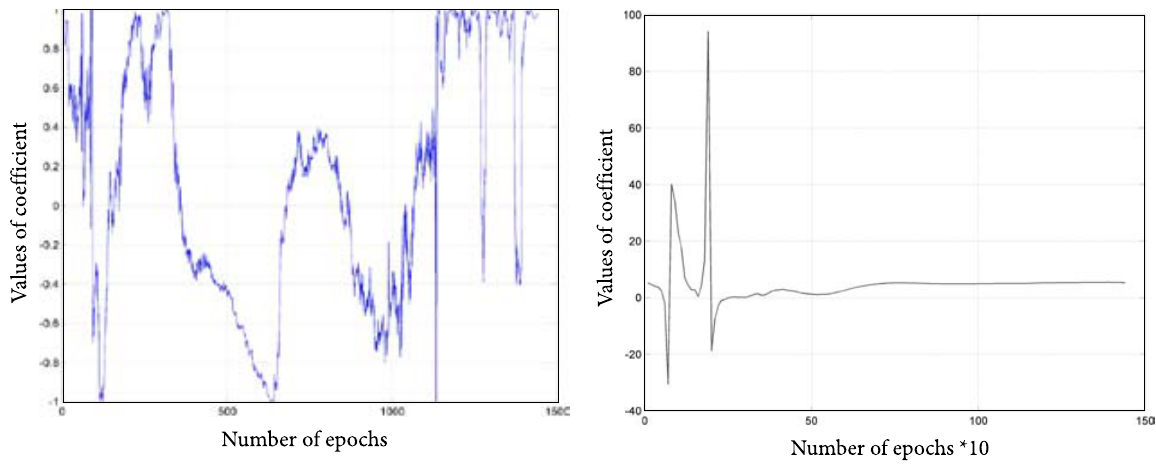
Fig. 2. Epoch-based variation of correlation coefficients of Fig. 5. Values of covariation variation coefficient h of F ( t ) F x ( t ), F y ( t ), F z ( t ) vectors, calculated from 2 nd day data from vectors from data of Belsk2 and Belsk30 observatories Belsk2 observatory